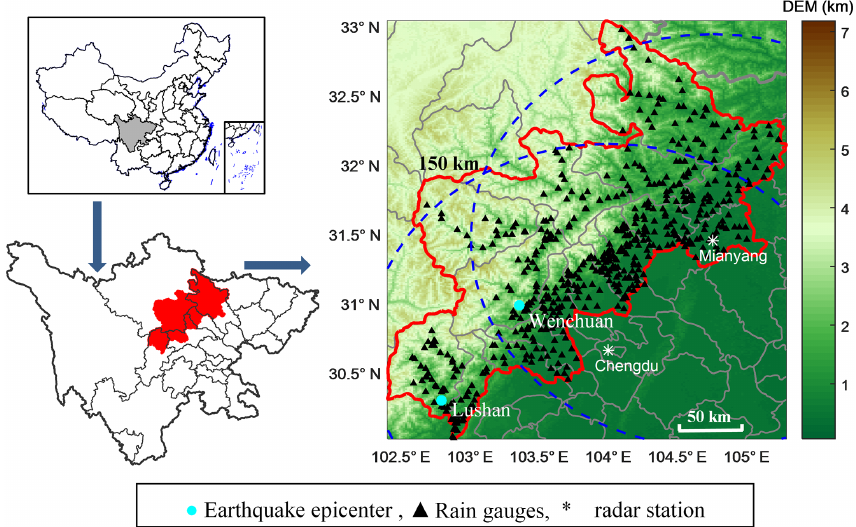
Figure 1. Location and topography of the study area. Asterisks show the location of Chengdu and Mianyang S-band weather radars which monitor the study area within 150km (dash black circle) from the radar location. Rain gauges in the study area are marked with black triangles and mostly deployed in the valley. The two blue circle dots are the epicenter of the M s 8.0 Wenchuan earthquake on 12 May 2008 and the M s 7.0 Lushan earthquake on 20 April 2013.